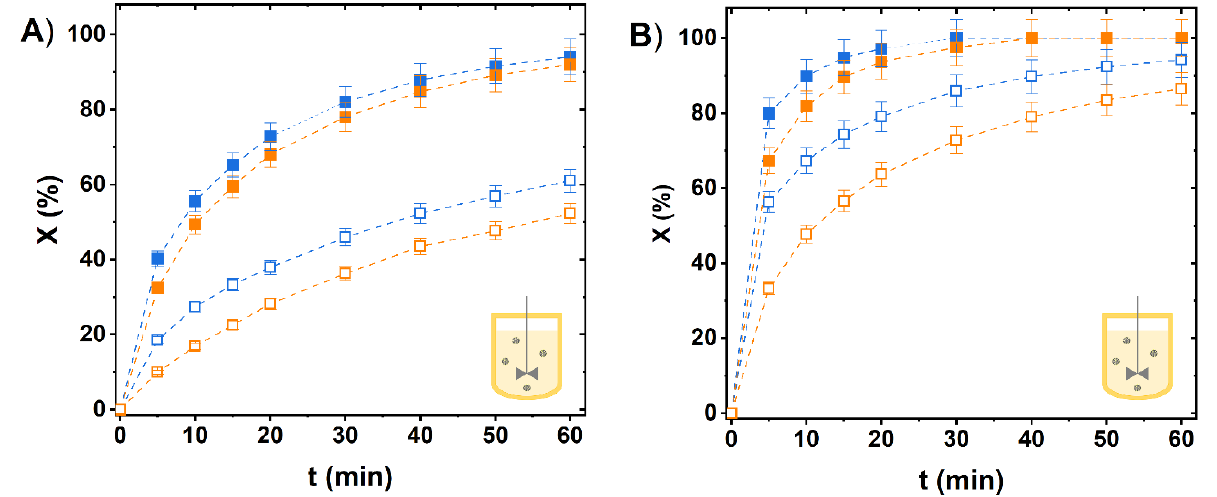
Figure 3. Conversion (X) time course of cellobiose catalyzed by different immobilized biocatalysts: Ag-Gly 2000 U _pNPG /g support (blue squares); Ag-PEI 2000 U _pNPG /g support (orange squares) at different enzyme concentrations ( A ) 0.90 U _pNPG /mL and ( B ) 4.50 U _pNPG /mL with different cellobiose concentrations (sodium citrate buffer 50 mM pH 5.0): 20 g/L (filled squares) and 70 g/L (empty squares). The data shown are representative of the multiple time ‐ course experiments repeated. All experiments were performed in batch reactors at 50 °C as reported in the experimental section.